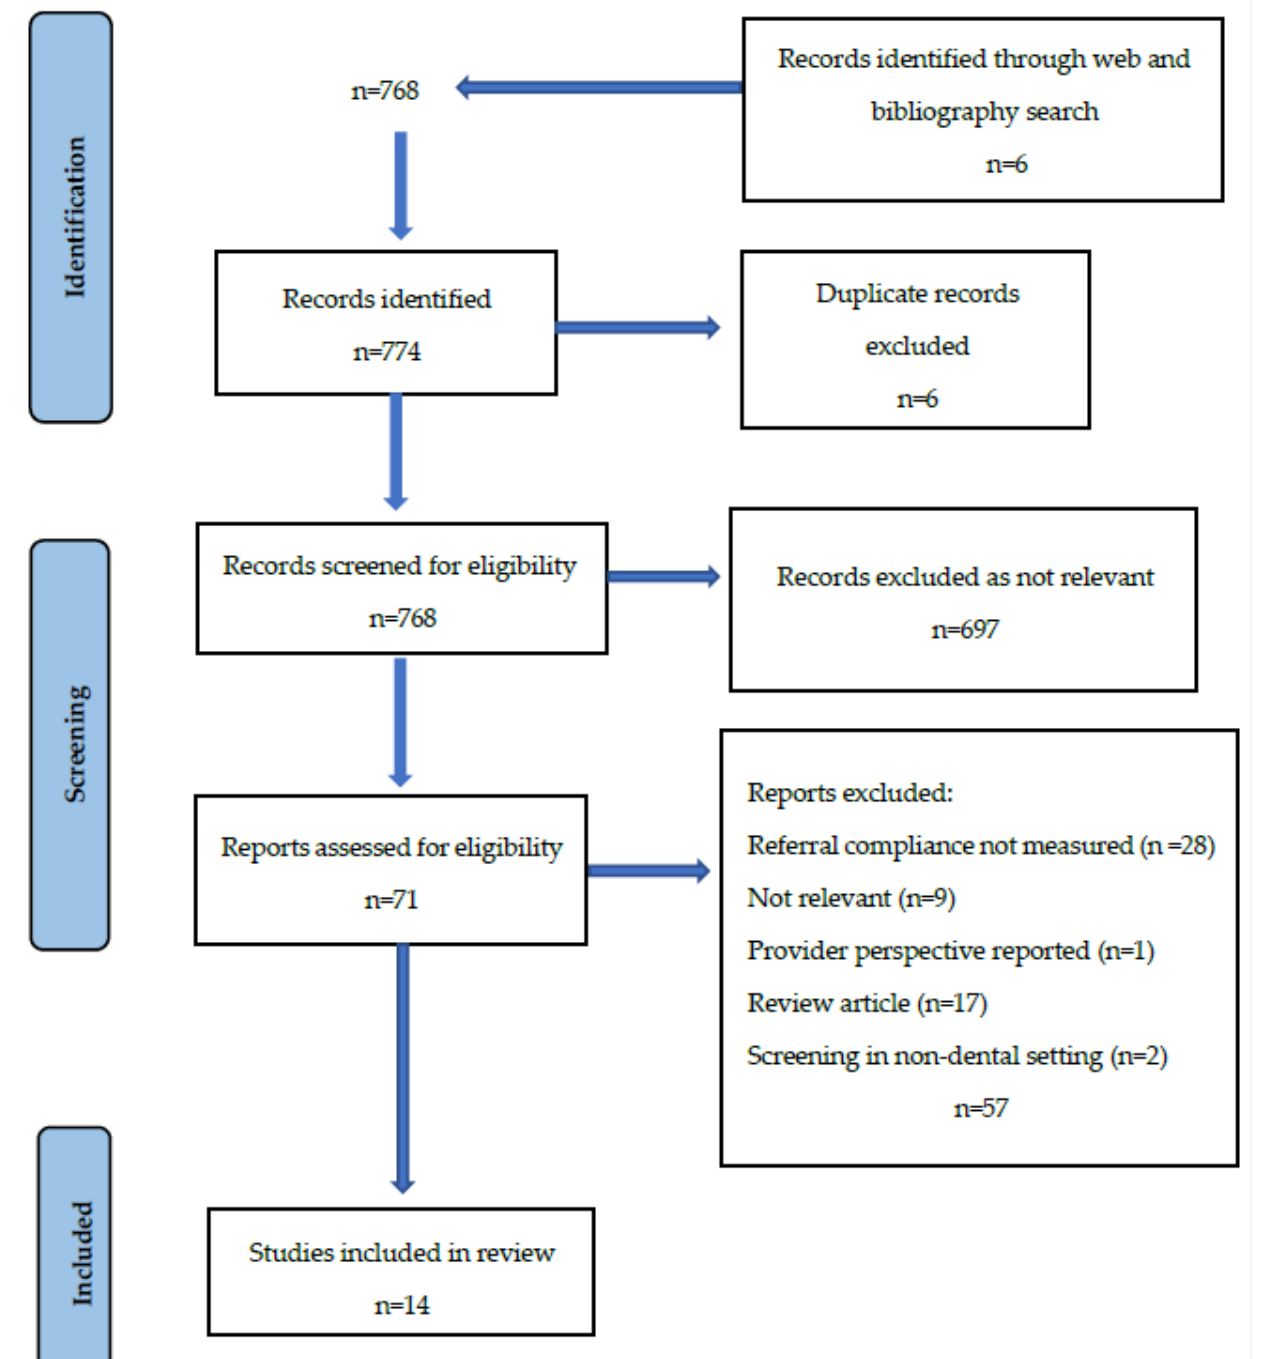
Figure 1. PRISMA flowchart of study selection process.